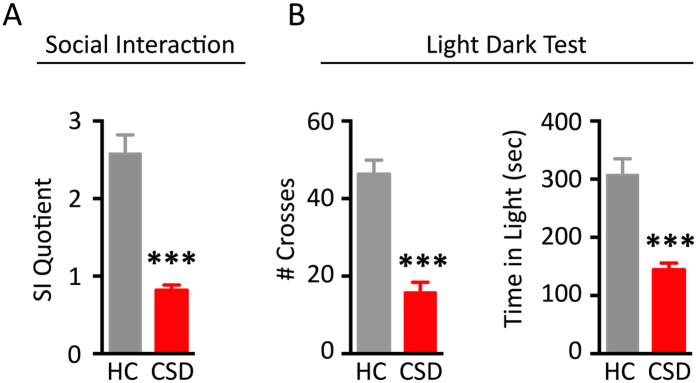
Chronic Social Defeat (CSD) significantly elevated depressive-like and anxiety-like behaviors in adult male mice.(A) In the social interaction task, CSD mice showed pronounced anti-social behavior measured by a significant decrease in preference for interacting with the CD-1 mouse. (B) In the Light/Dark test for anxiety, CSD mice showed a significant reduction in crosses between chambers, and spent more time in the dark compartment compared to HC mice. Results are expressed as mean ± SEM (n = 6 per group). Unpaired two-tail t-test: ***p < 0.001.